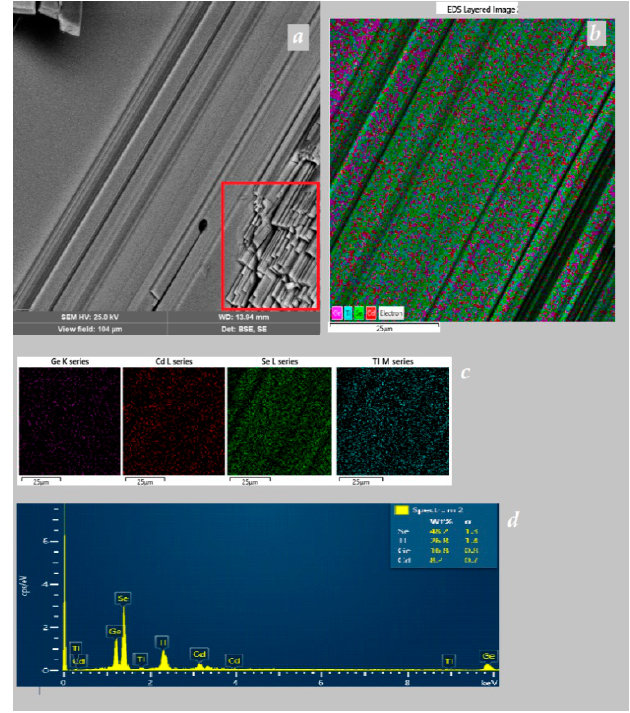
Figure 3. SEM/EDS results of the Tl 2 CdGe 3 Se 8 sample: microphotograph of the sample chip ( а ), EDS results with general mapping, element mapping, elemental composition ( b – d